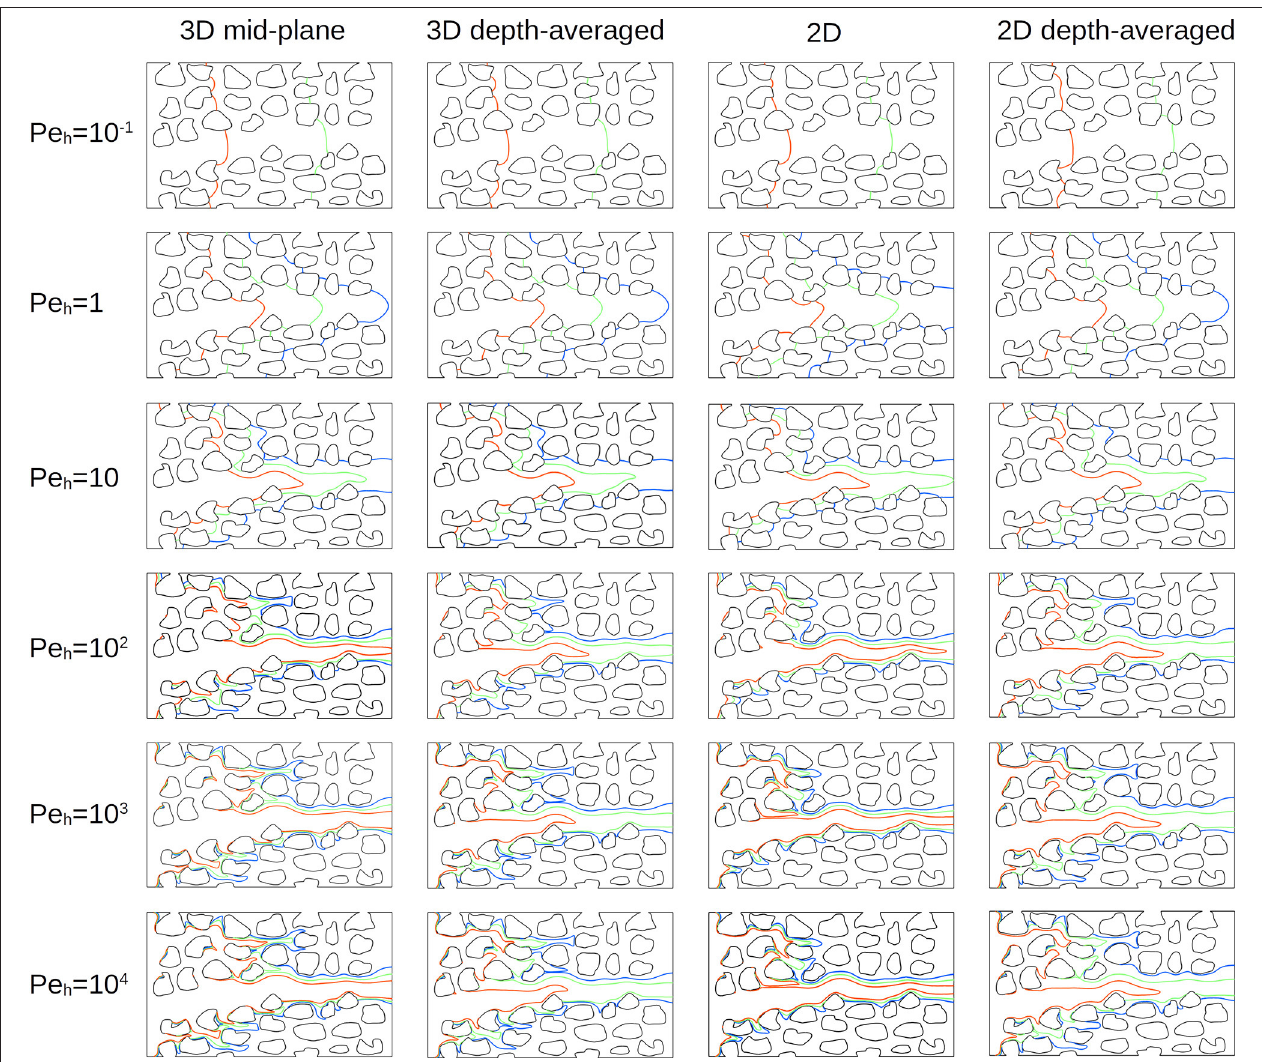
FIGURE 3 | Transport of a scalar in a micromodel with aspect ratio h / d > 1. We use 3D, 2D, and 2D-depth-averaged models for different Péclet number by varying the diffusion. The results correspond to isocontour of the concentration for C = 0.2 (blue), C = 0.5 (green), C = 0.8 (orange) at t = 42s. 2D models without dispersion break down for Pe h >